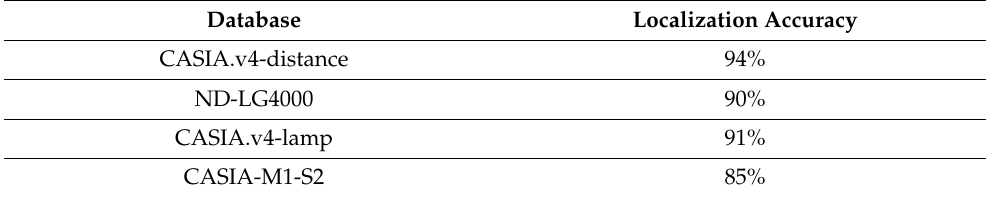
Table 2. Accuracy of iris localization.